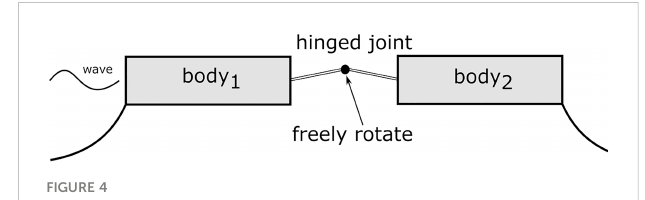
FIGURE 4 An exemplary multibody platform, connected by a hinged